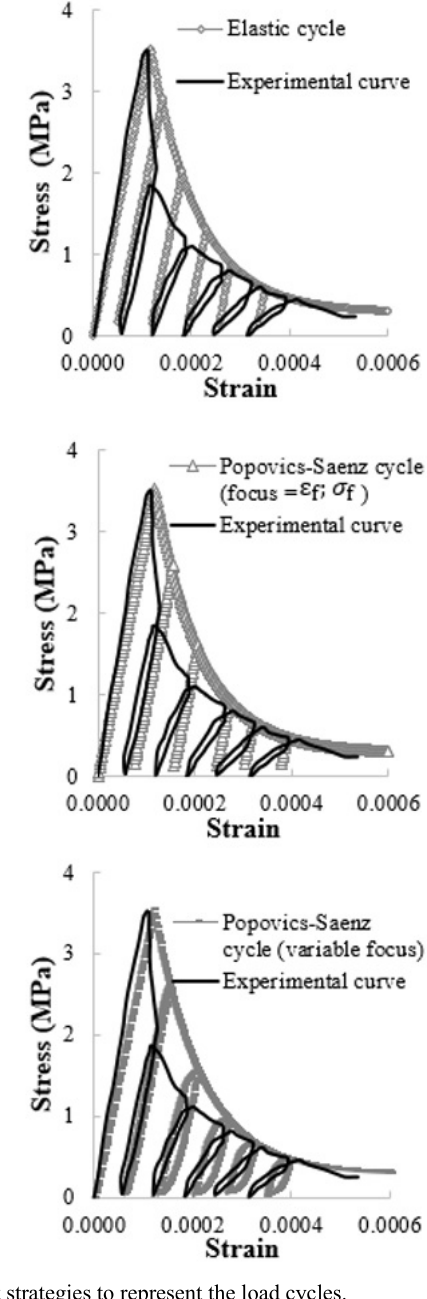
Figure 9. Direct tension simulations: different strategies to represent the load